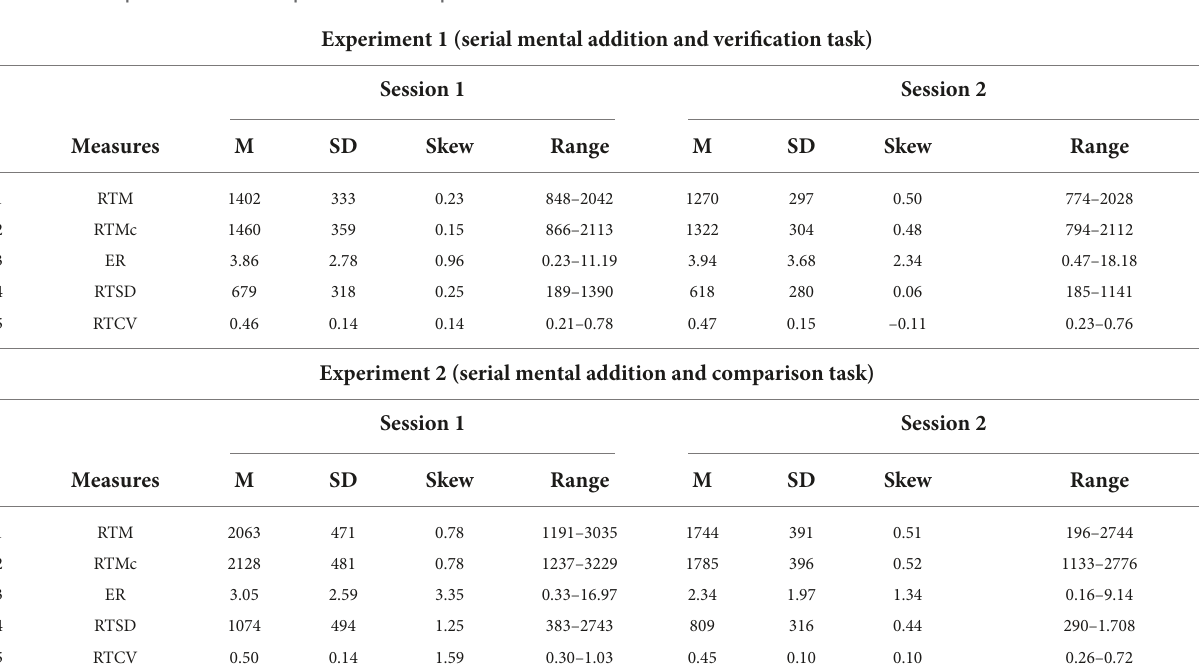
TABLE 2 Descriptive statistics for Experiment 1 and Experiment